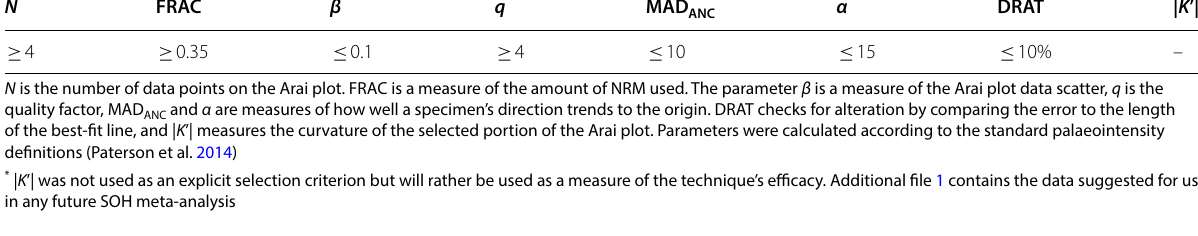
a Based on the estimates from Teanby et al. (2002) and Gratton et al. (2005)